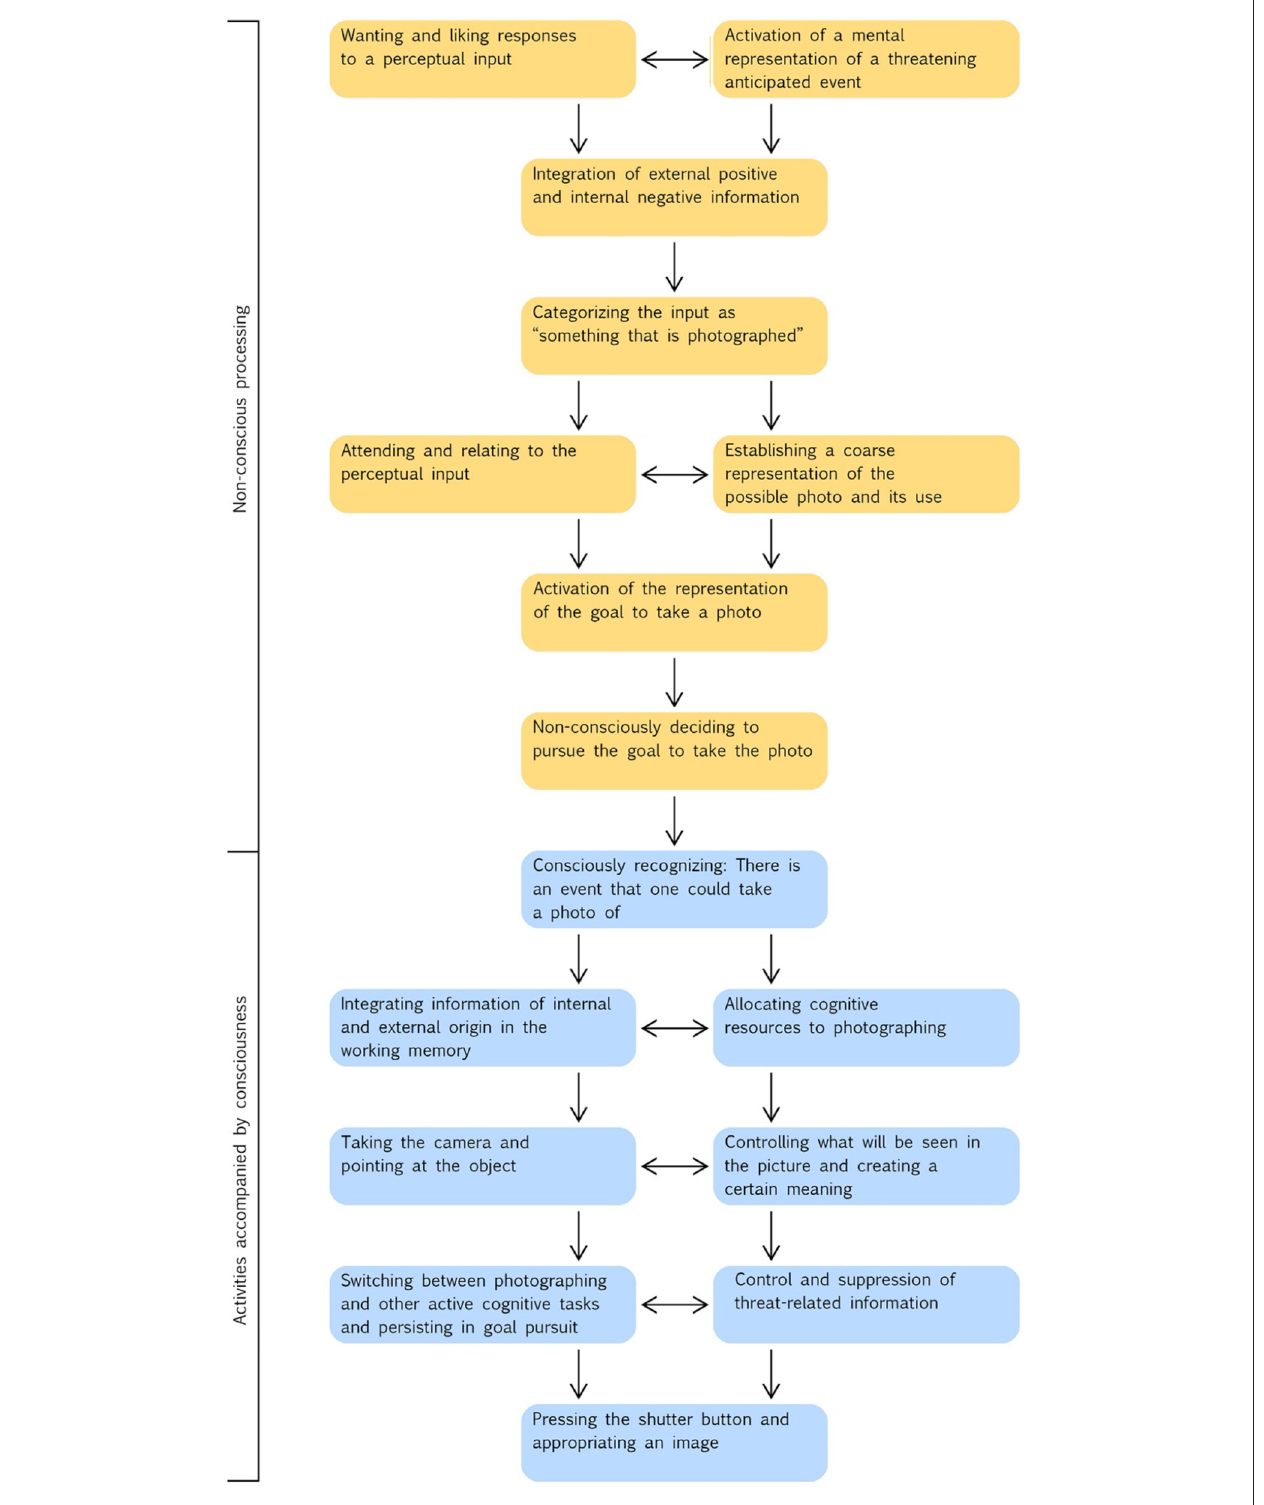
FIGURE 1 | Hypothetical process model including the major processes and activities that occur in an individual who engages in taking a personal photo. The place within the sequence where the processes and activities are located indicates either when they occur or when they first occur. In order to keep the presentation clear, possible feedback effects of activities on the antecedent steps are not shown. Downward arrows mean “then occurs”; a horizontal arrow means “interacts with”.